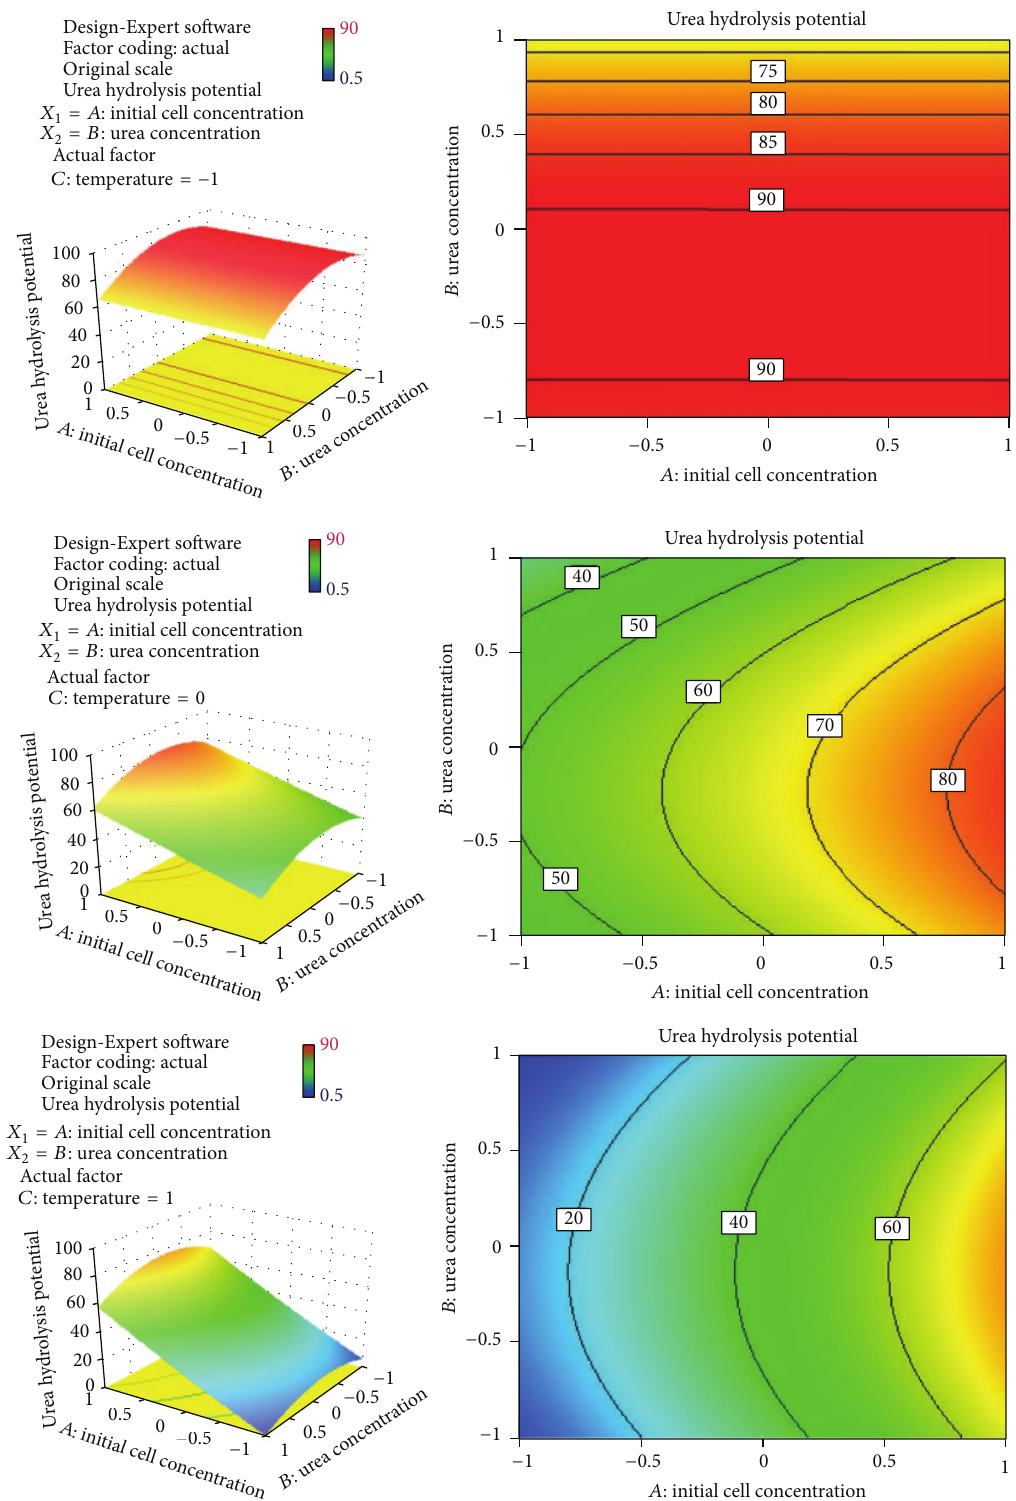
Figure 6: Response surface plots of the mutual effect of the factors on the urea hydrolysis